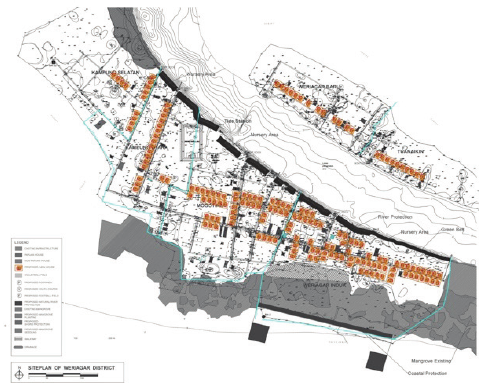
Figure 6. Arrangement pattern of social facilities